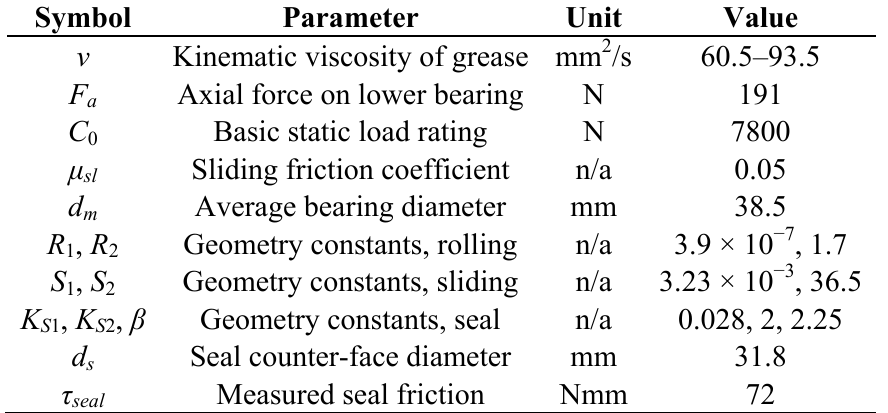
Table 7. Parameters used in the calculation of power loss due to mechanical bearings. All parameters for a given bearing geometry and lubrication can be found in [19] and